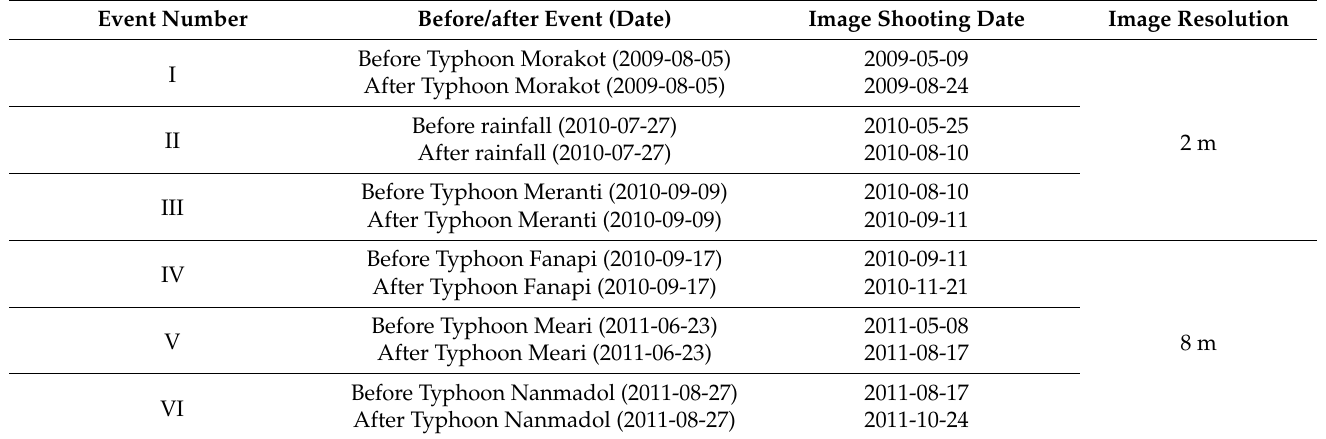
Table 2. Basic data of satellite